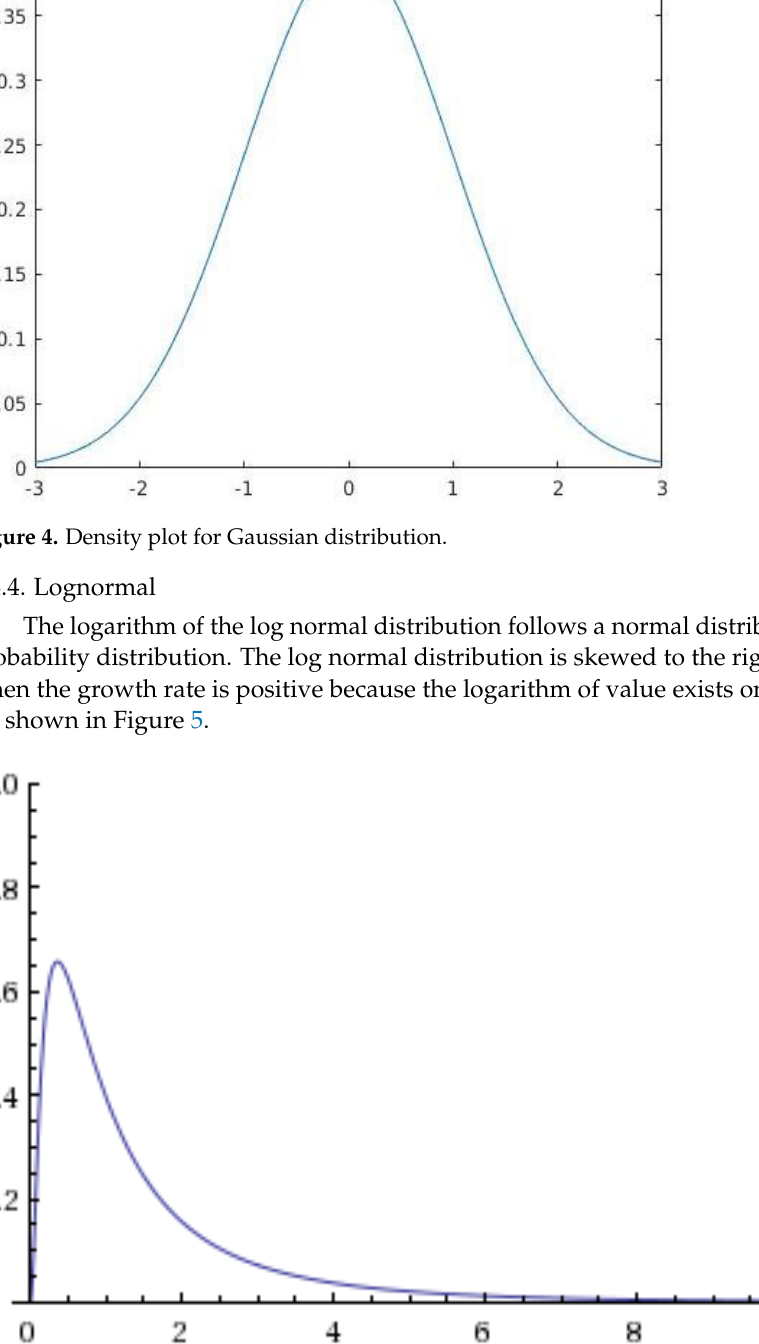
Figure 5. Density plot for lognormal distribution.